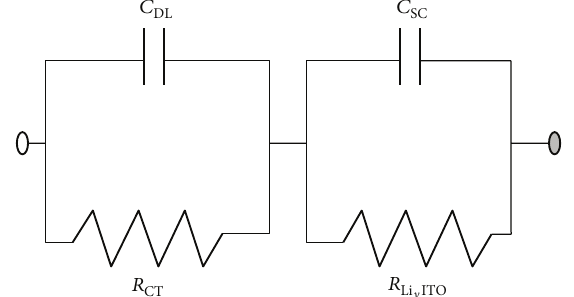
Figure 5: Proposed scheme of equivalent circuit for lithiated ITO Li 𝑦+𝑧 Sn 𝑥 In 2−𝑥 O 3 polarized at 1.2 and 2.7 V versus Li +